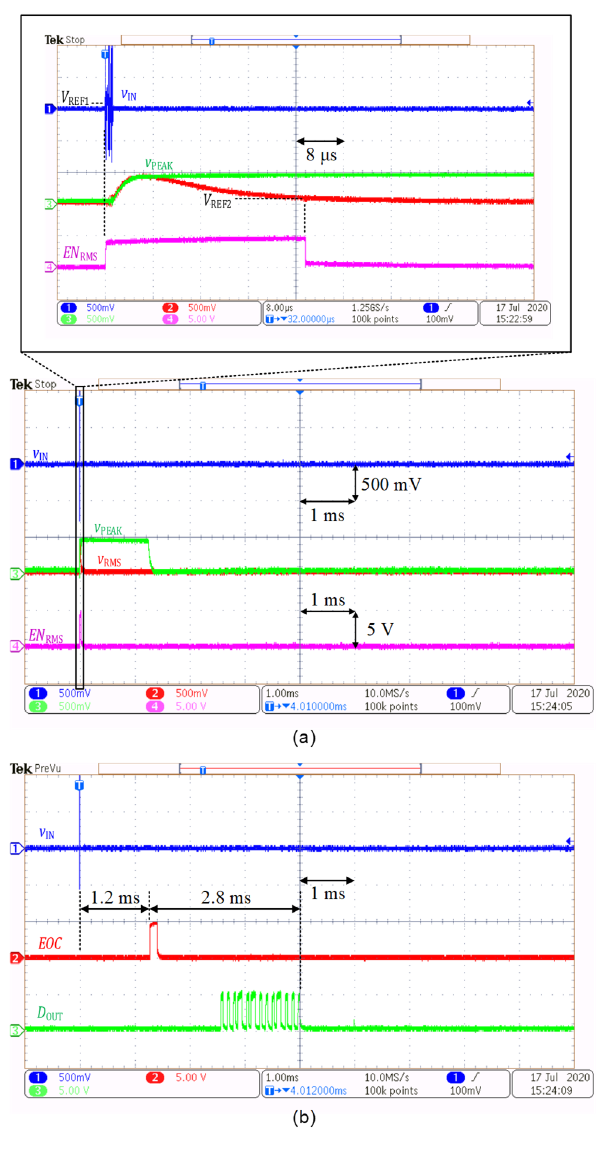
Figure 13. Experimental results for transient waveforms in the proposed event-driven monitoring system. ( a ) Detecting vpeak out of vRM and ( b ) its data transmission.